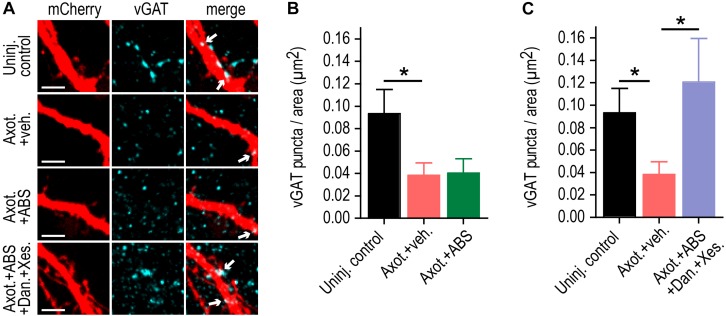
ER calcium channel activation at the site of injury is required for retrograde inhibitory terminal loss post-axotomy. (A) Representatrive mCherry labeled dendritic segments immunostained for the inhibitory presynaptic marker, vGAT, at 48 h following application of vehicle or local activity blockade solution (ABS) with or without Dantrolene and Xestospongin C to axons for 1 h during axotomy. Arrows in the merge image indicate the localization of vGAT puncta (cyan) on mcherry labeled dendrites (red). Scale bar, 5 μm. (B,C) Number of vGAT puncta per neuron area (uninjured control, axotomy or axotomy + ABS and axotomy + ABS + Dan + Xes) at 15-16 DIV. n = 6–8 neurons; 3 chambers per condition over 2 independent experiments. Error bars, SEM. ∗p < 0.05.